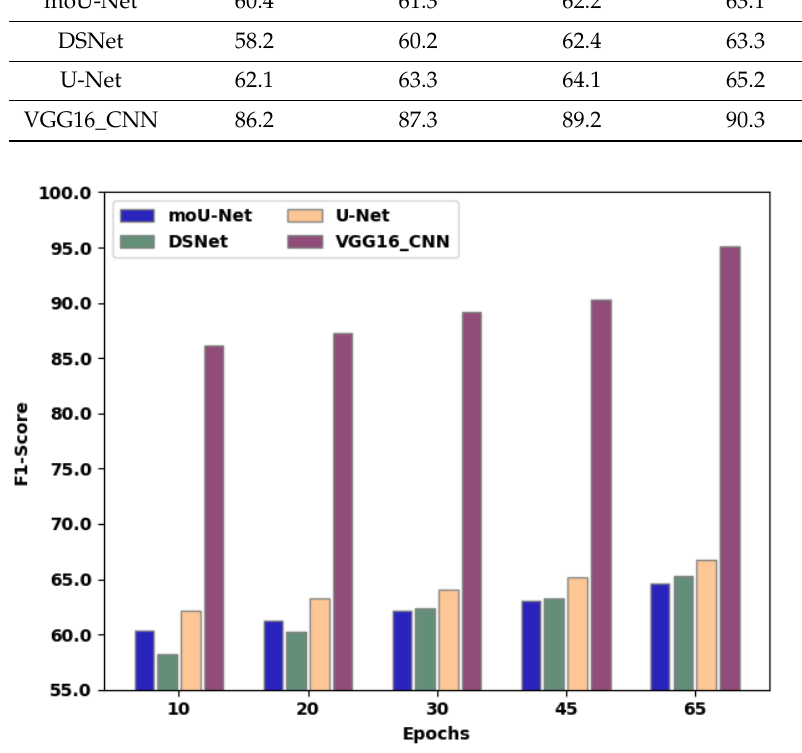
Figure 11. F1-score comparison of the existing techniques and proposed method.